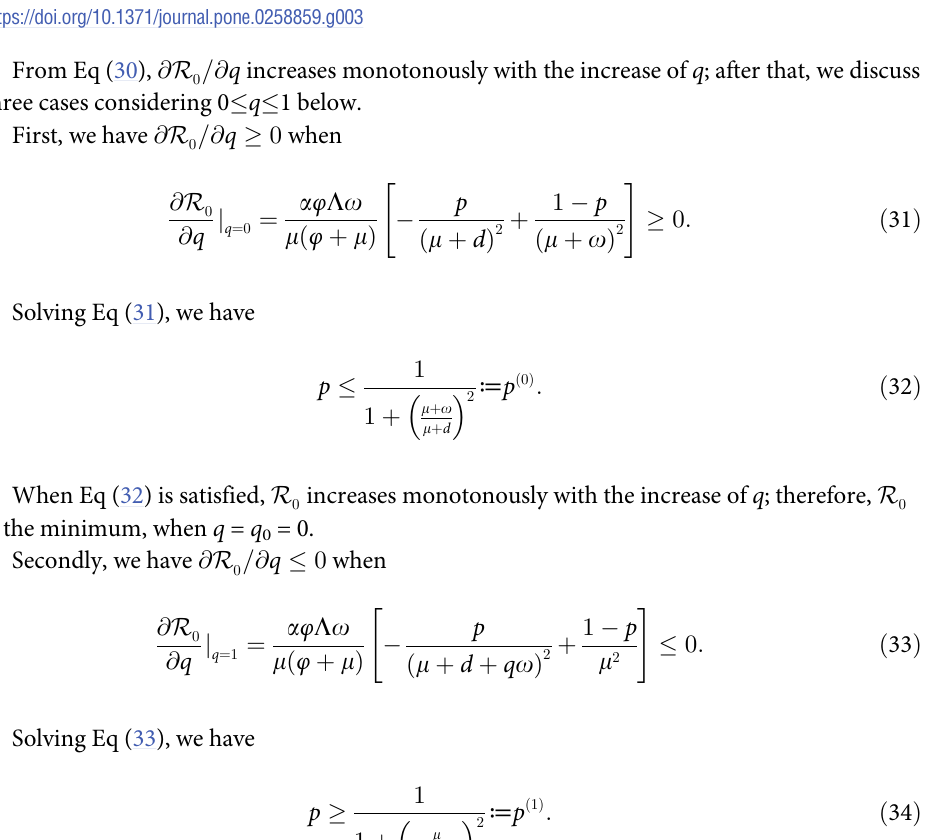
Fig 3. Time evolution of the population. Λ = 2, μ = 0.05, d = 0.9, α = 0.05, φ = 0.3, ω = 0.8, p = 0.4, q = 0.4, such that